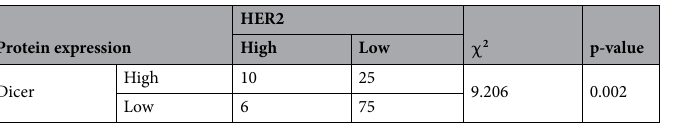
Table 1. Correlation between dicer protein level and HER2 protein level in GC patients by χ 2 test. HER2 2 + and 3 + were defined as high expression, HER2 0 and 1 + were defined as low expression.